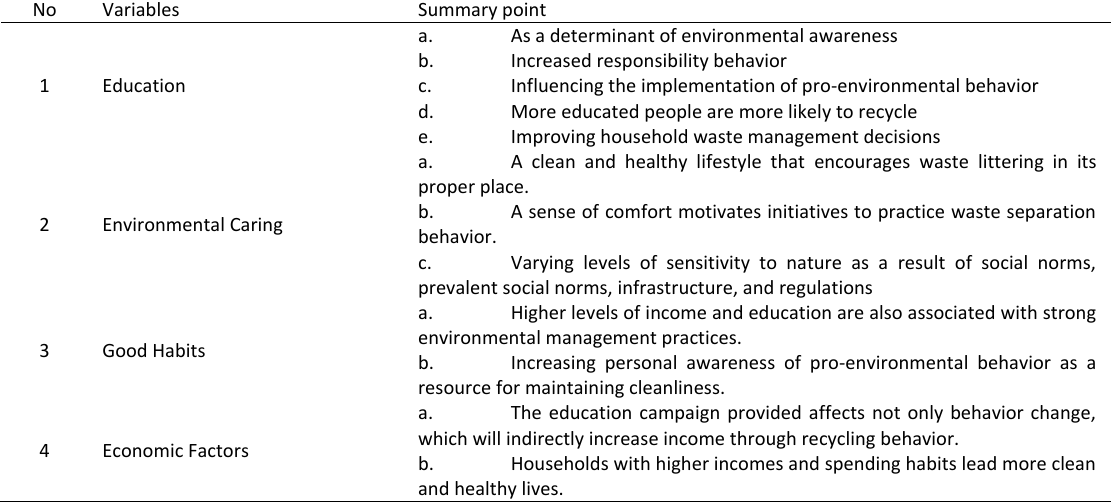
Table 3: Summary point with the individual littering behavior